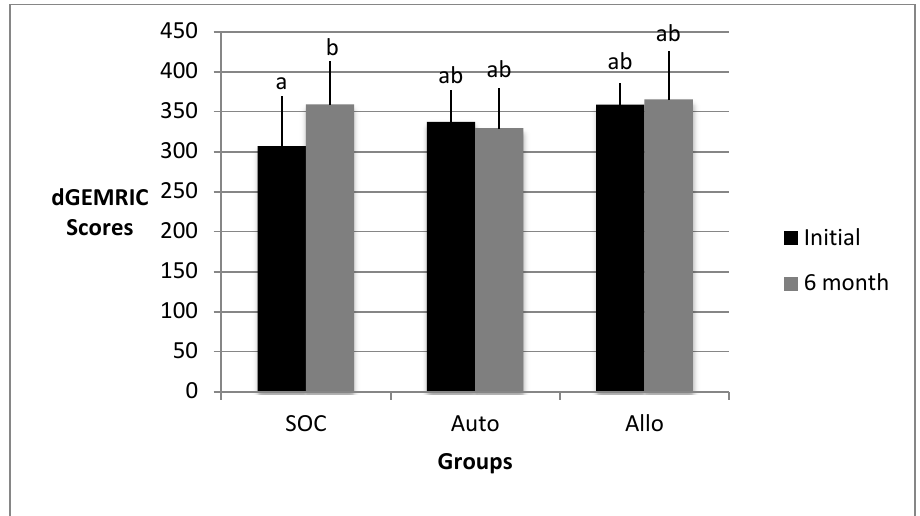
Figure 5: Comparison of dGEMRIC scores between initial and follow-up assessments. Averaged delayed gadolinium enhanced magnetic resonance imaging (MRI) of cartilage (dGEMRIC) score for each group depicted on the y-axis. Each treatment group is depicted on the x-axis at initial assessment (black) and 6 month recheck (grey) side by side. Treatments consisted of standard of care (SOC), autologous (Auto) or allogeneic (Allo) cell therapies. Letters above columns are to distinguish statistical significance. Columns labeled with the same letter indicate no statistical significance between scores. Columns that do not share a common alphabetic letter are p<0.05 and are considered statistically